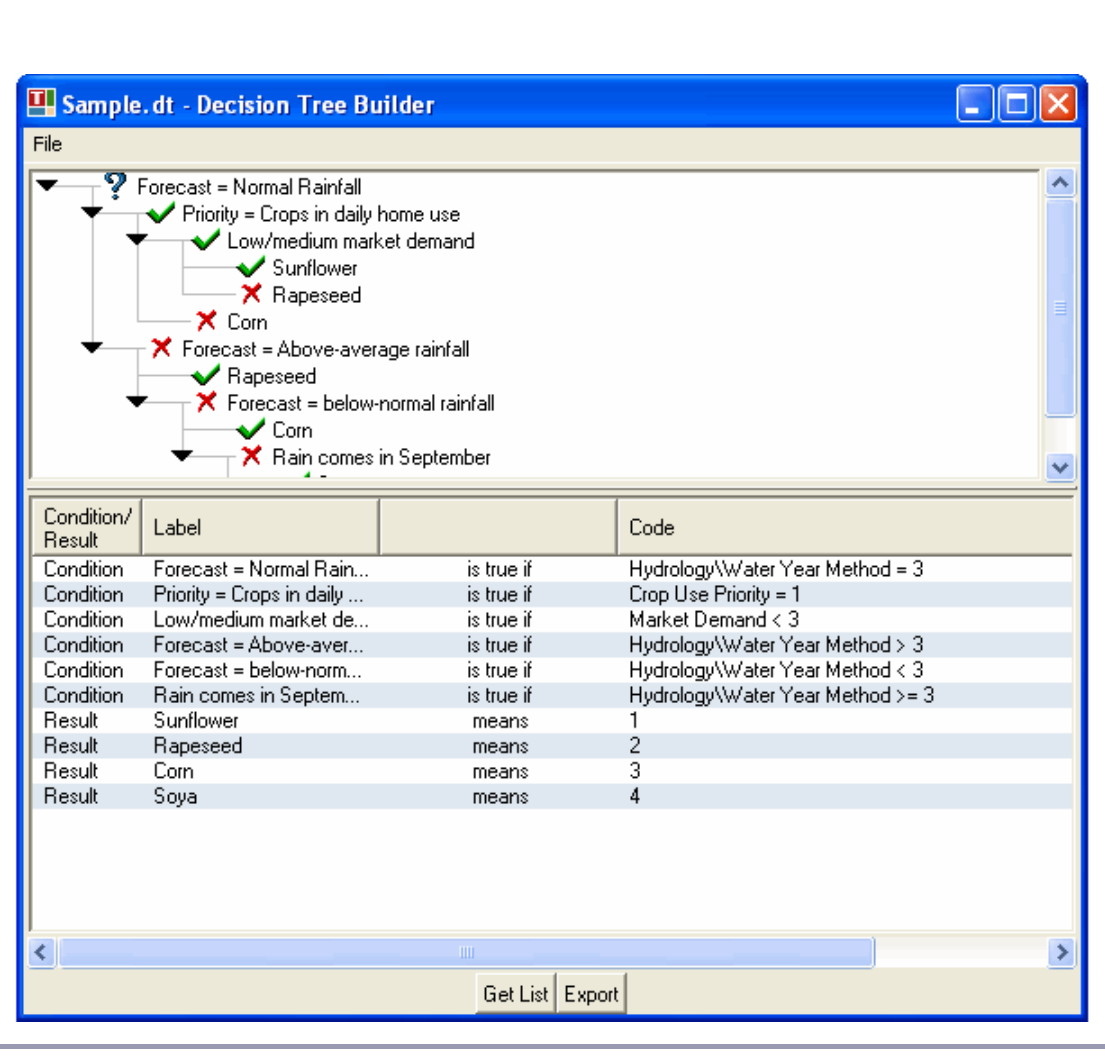
Fig. 4 . Decision tree